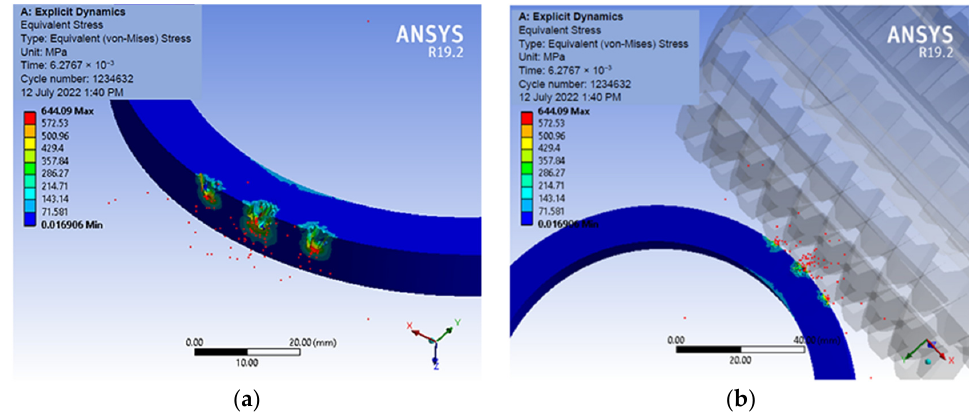
Figure 7. Computed ANSYS equivalent (von Mises) stress map: ( a ) for the gear; ( b ) global view of the assembly.